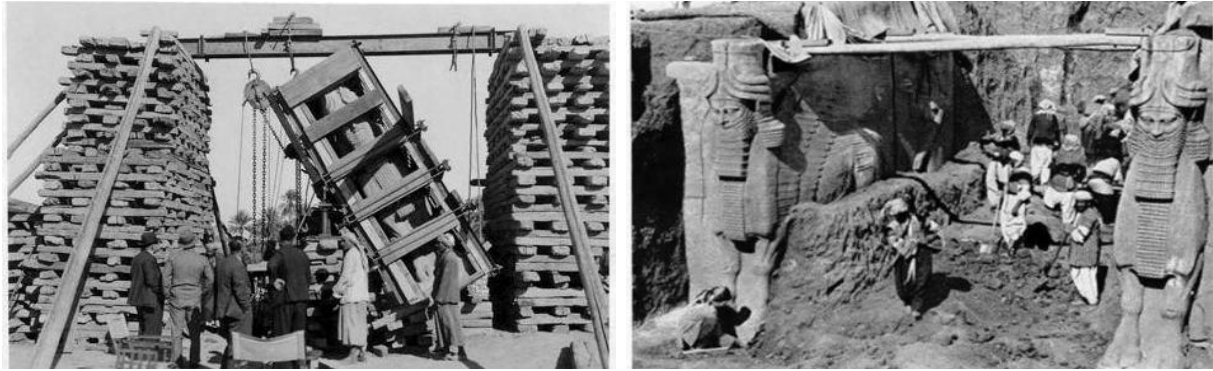
Figure 10. Gate of Sargon II’s citadel excavation, Khorsabad